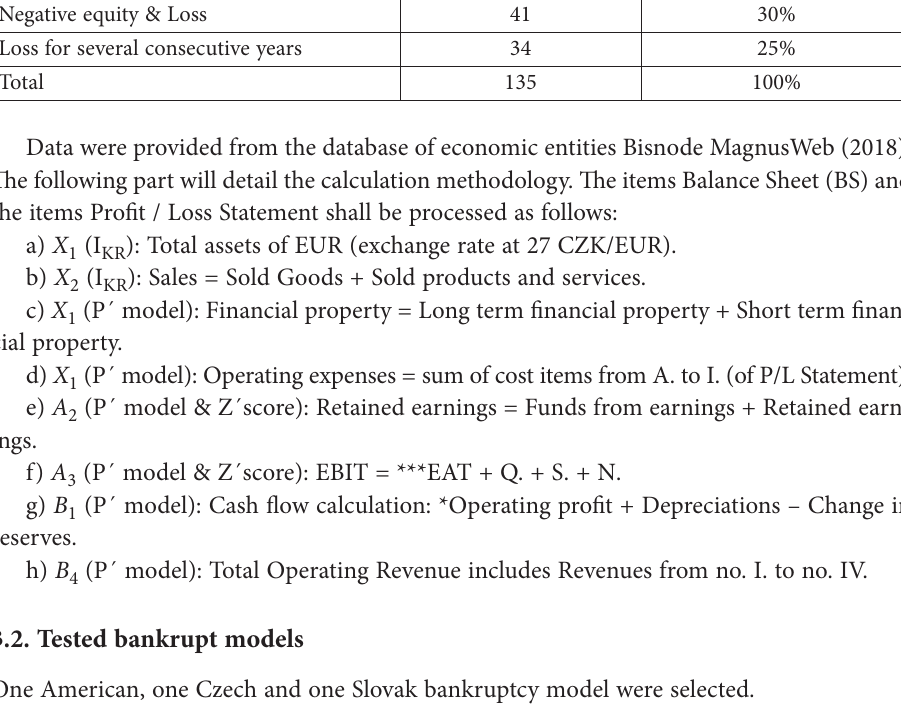
Table 1. Frequency of negative events (source: authors) Negative events Absolutely Relatively Negative equity 82 61% Loss 63 47% Negative equity & Loss 41 30% Loss for several consecutive years 34 25% Total 135 100% Data were provided from the database of economic entities Bisnode MagnusWeb